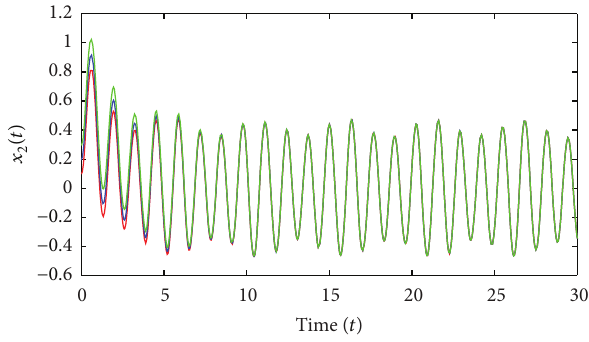
Figure 3: Global exponential stability of state variable 𝑥 2 (𝑡)